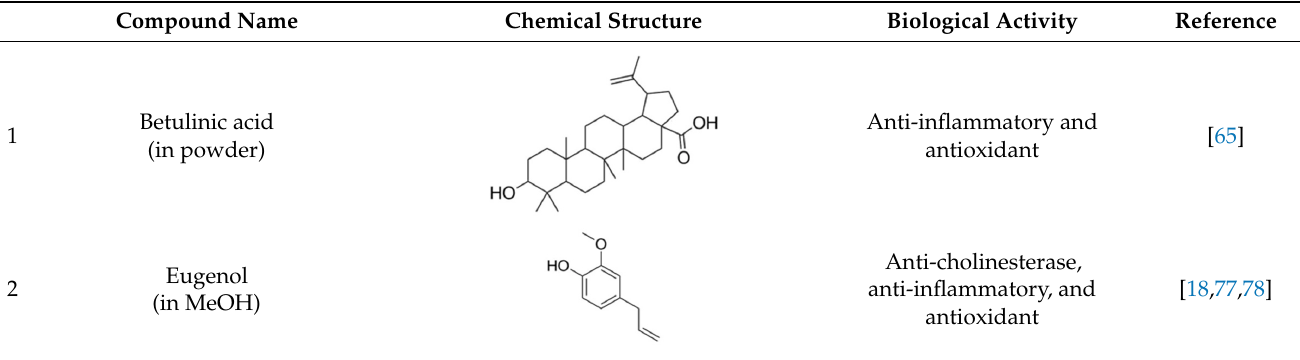
Table 5. Reported bioactive principles for neuroprotection from Syzygium species.